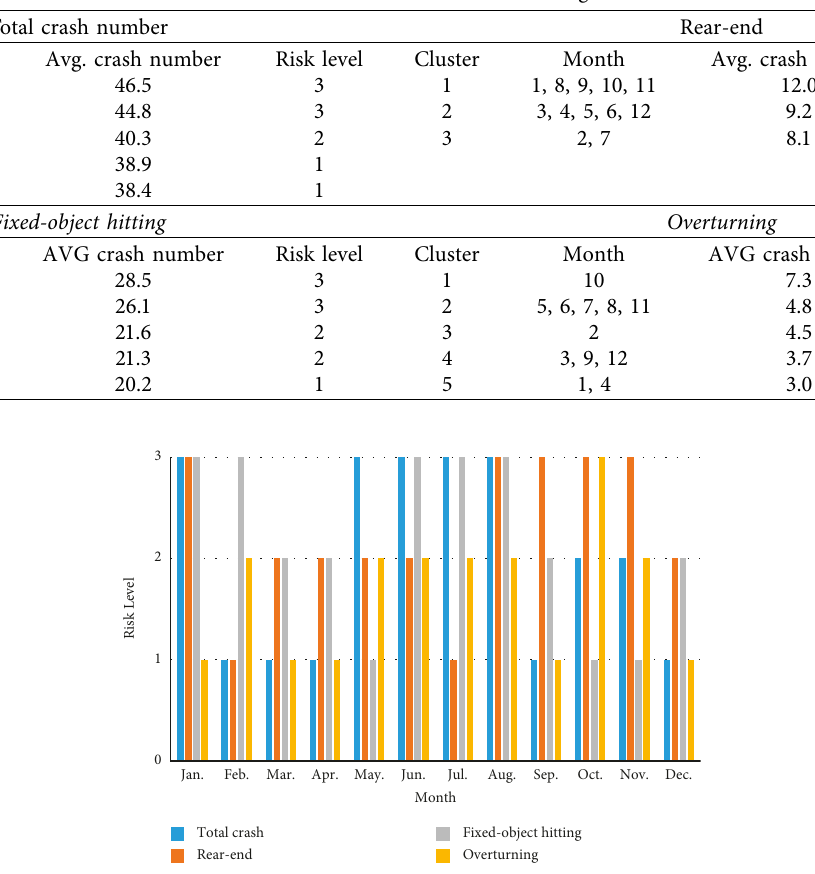
Figure 5: Monthly distribution pattern of various types of crashes based on K